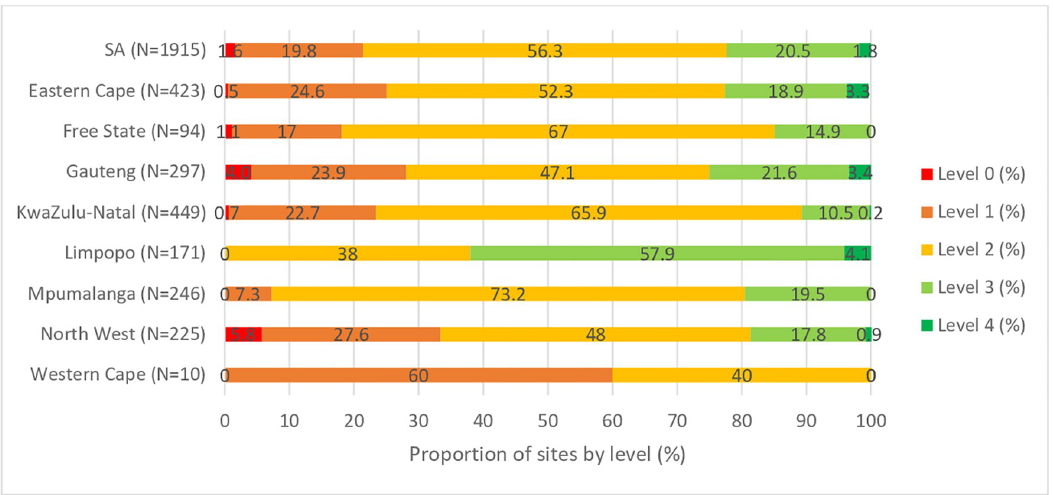
Fig 3. Distribution of HIV testing facilities by performance levels across 32 priority districts of South Africa in assessment round-one (N = 1,915) conducted between 18th of April 2015 to 13th of December 2017, SPI-RT assessment, South Africa.